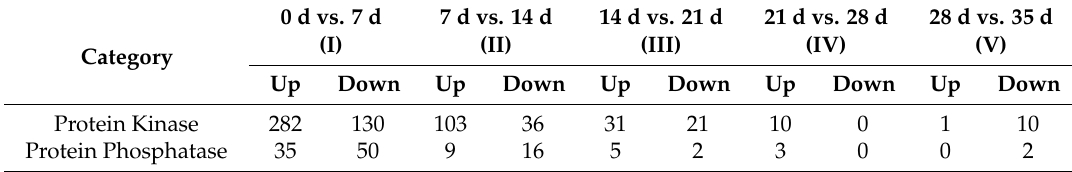
Table 2. DEGs number involved in protein phosphorylation of cold-stored loquat